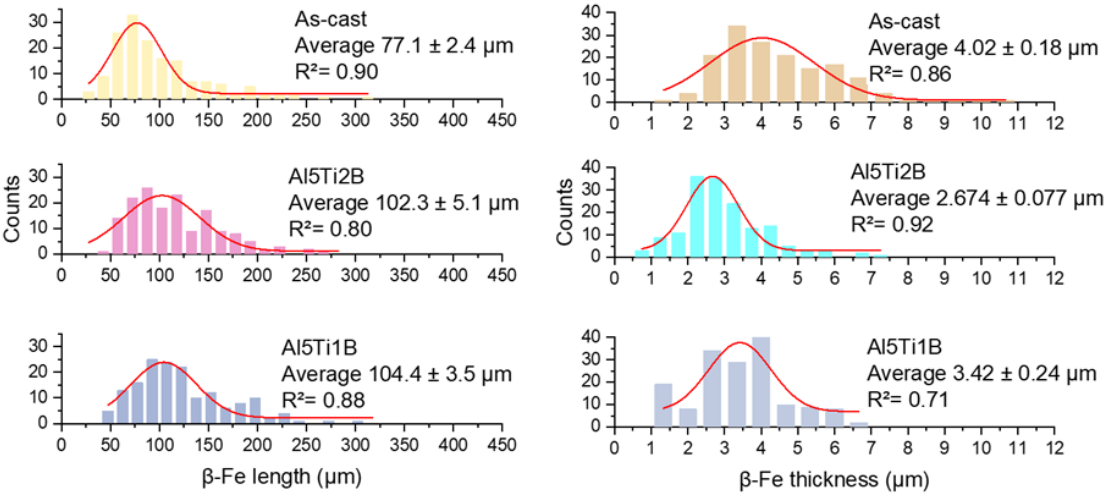
Figure 6. Length and thickness of the intermetallic beta iron (Al5FeSi).